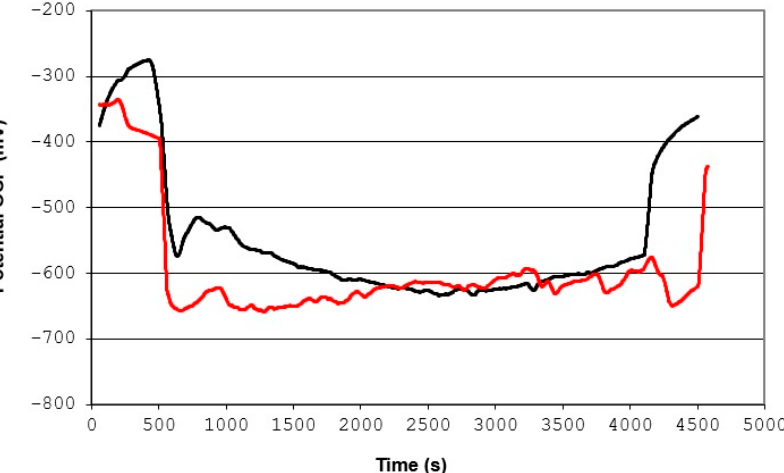
Figure 8. Time evolution of the potential during the tribocorrosion test for the tested coatings at an open circuit potential, E OCP : Cr/CrN PVD (the red line) and gas nitrided with subsequent oxidation and impregnation (the black line)